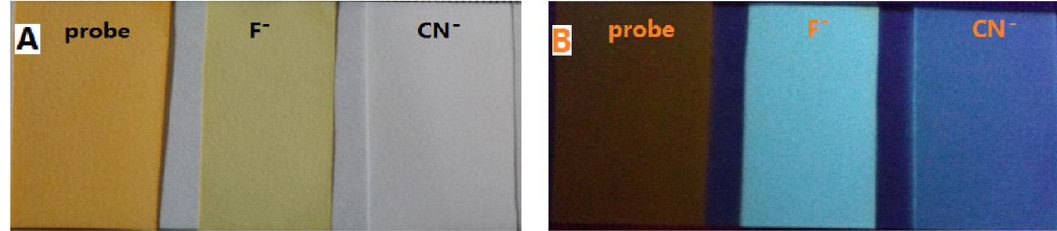
Figure 2. Colour change ( A ) and emission change ( B ) changes of A5 -coated test strips upon exposure